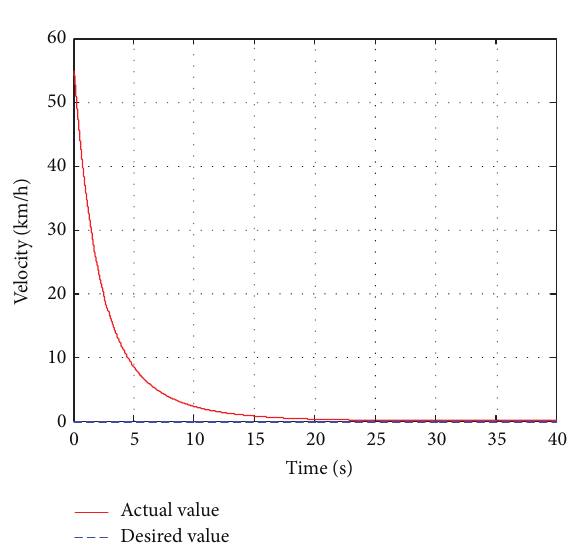
Figure 10: The vehicle velocity.